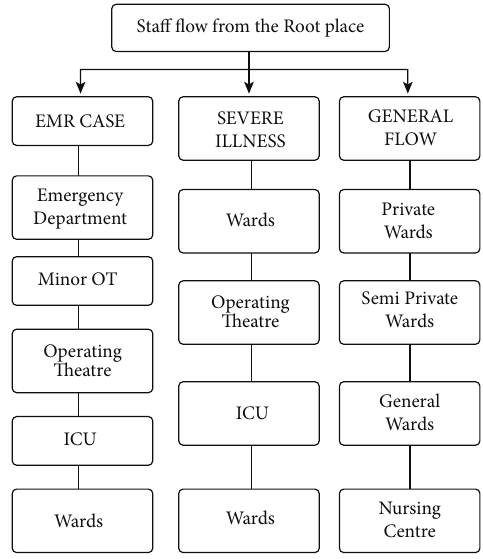
Figure 8. Types of staff flow